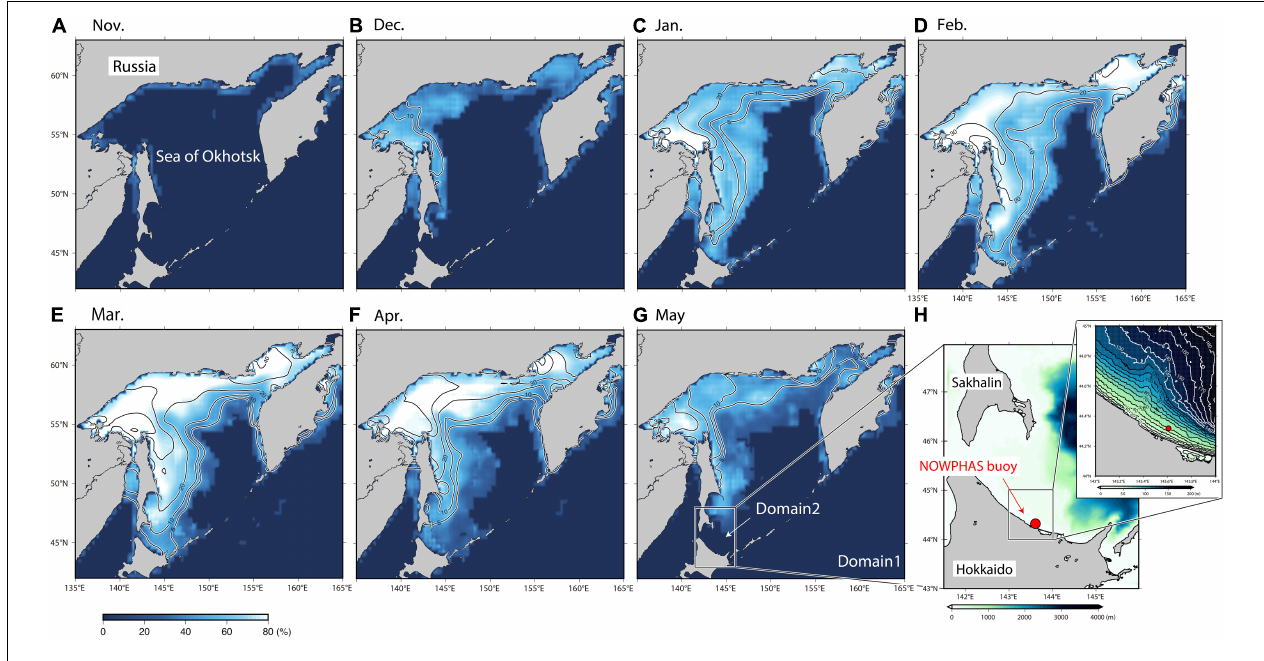
FIGURE 1 | Monthly ice concentration (color) and ice thickness (contour) from November to May during 2008–2010 incorporating two model domains. (A–G) Represent the ice concentration and ice thickness derived from NOAA OI SST V2 and CFSR, respectively. CFSR ice thickness (cm) were smoothed with a two-dimensional boxcar filter with a width of 50 km. (H) Map of the NOWPHAS buoy location (red dot) and the GEBCO, 2020 bottom topography (color). The upper right figure is an enlarged image of the buoy location and bottom topography (color with contours).